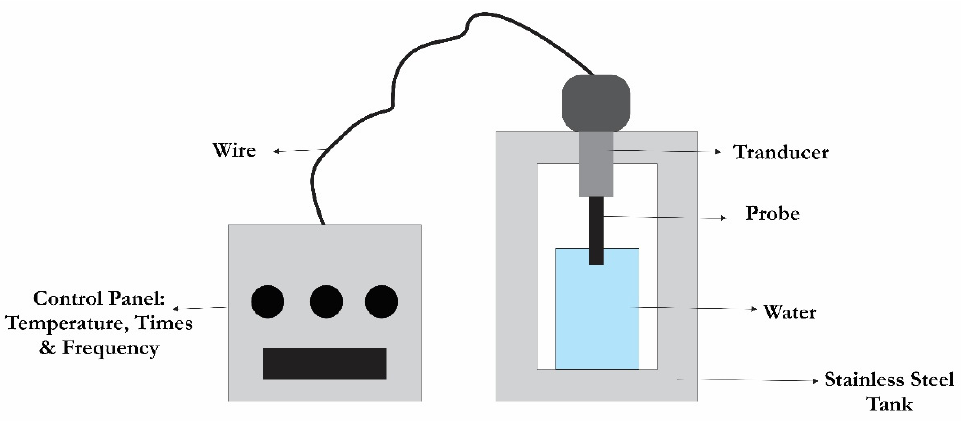
Figure 3. Ultrasonic probe mode.